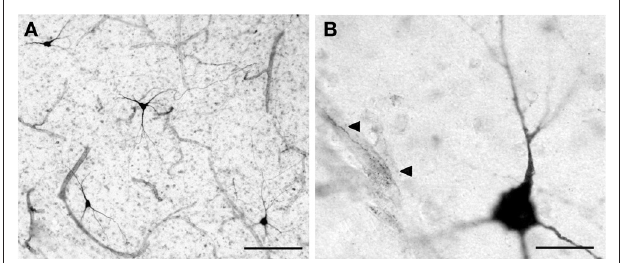
FIGURE 4 | (A) Type 1 NADPH-d + neurons in the superfi cial WM. (B) Magnifi ed view of a type 1 neuron near a microvessel that is contacted